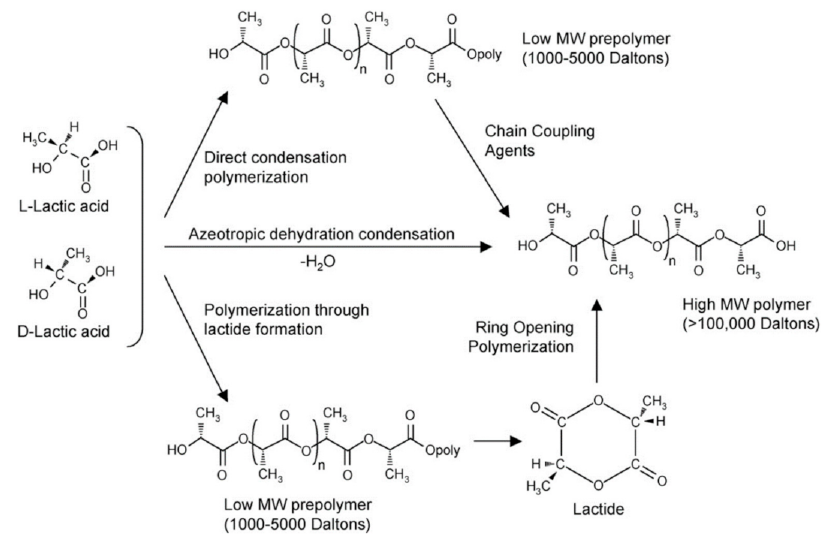
Figure 2. Synthesis of polylactic acid (PLA) from l - and d -lactic acids [28]. Adapted from Auras et al. by permission of Wiley–VCH Verlag GmbH & Co.